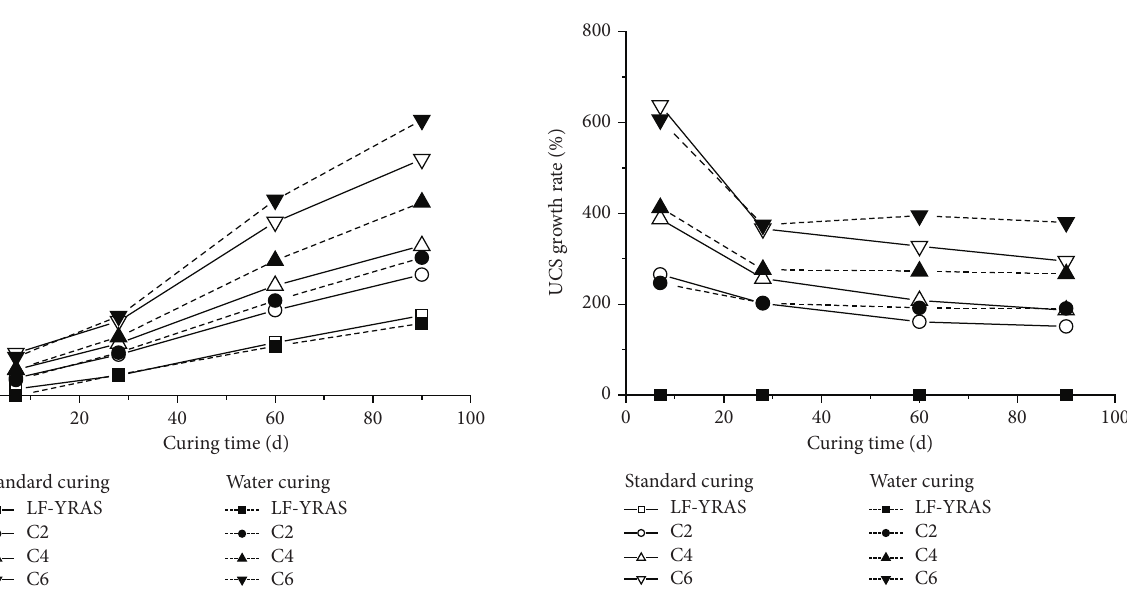
Figure 3: UCS test results of LF-YRAS, C2, C4, and C6 after curing for 7d, 28d, 60d, and 90 d.